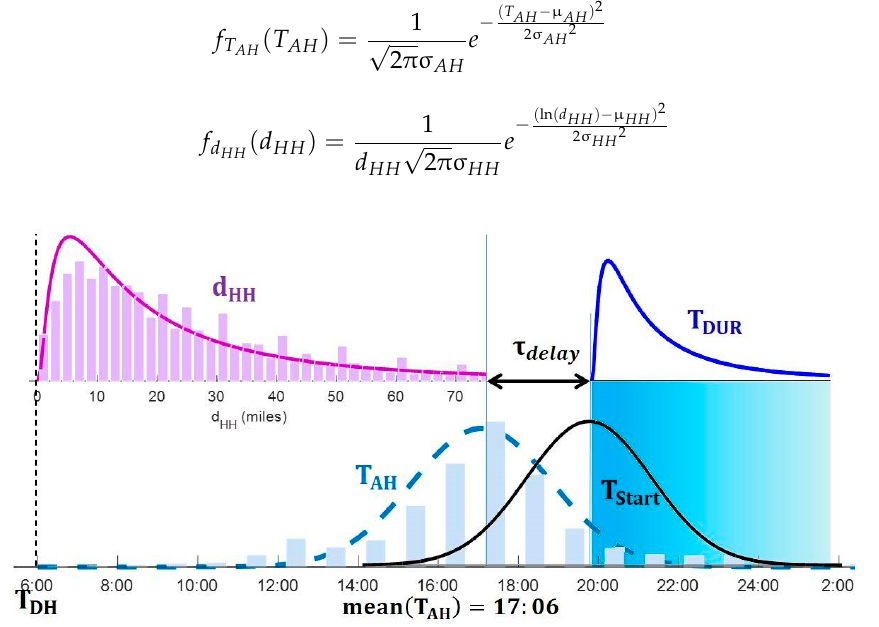
Figure 1. Stochastic modeling of plug-in electric vehicle (PEV) travel distance and charging schedule.